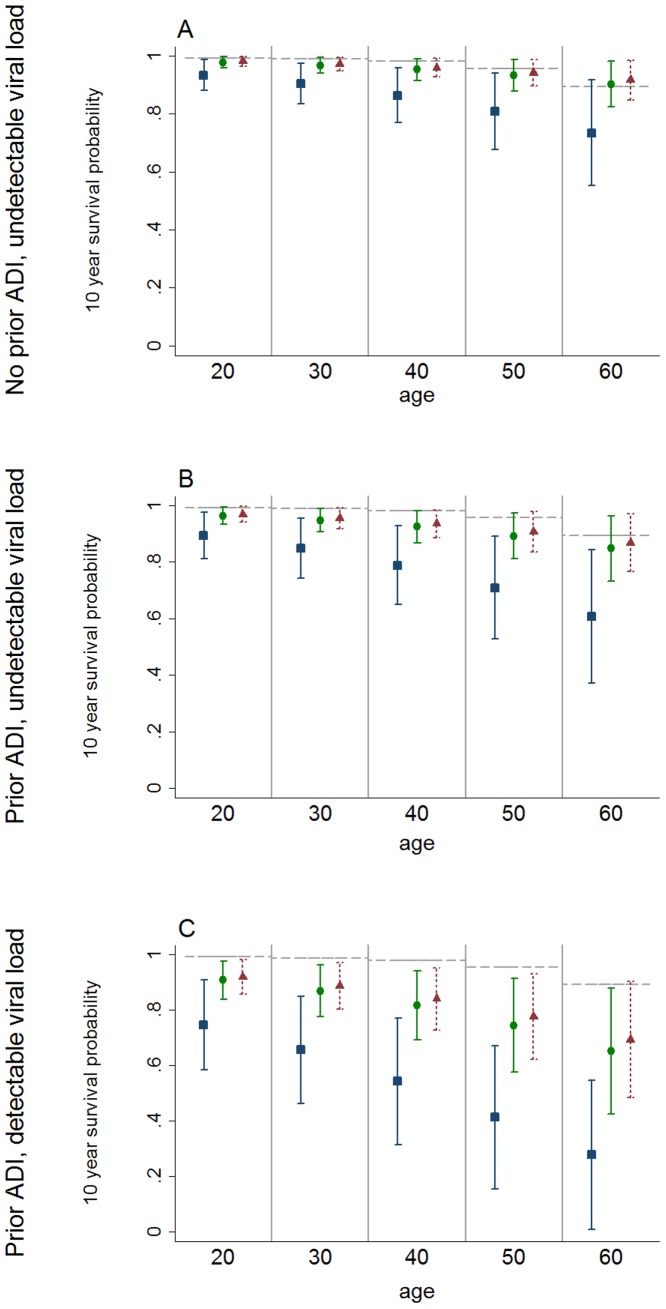
10 year survival probabilities and 95% confidence intervals by age and time updated CD4 count.Blue/square markers represent patients with CD4 less than 350 cells/µl. Green/round markers represent patients with CD4 from 350 to 499 cells/µl. Red/triangular markers represent patients with CD4≥500 cells/µl. Grey/horizontal dashed line represents Australian males 2008–09. These plots apply to patients on 4th or greater regimen, no prior HBVsAg, non-IDU mode of exposure and specified existing viral load and incidence of ADI. Plot (A) shows 10 year survival probabilities for patients with viral load ≤400 copies/ml and with no prior ADI. Plot (B) shows 10 year survival probabilities for patients with viral load ≤400 copies/ml and with prior ADI. Plot (C) shows 10 year survival probabilities for patients with viral load >400 copies/ml and with prior ADI.